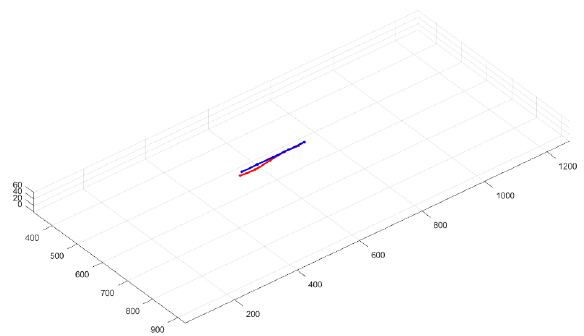
Figure 9. The actual curve (blue) and the calculated curve (red) of the target